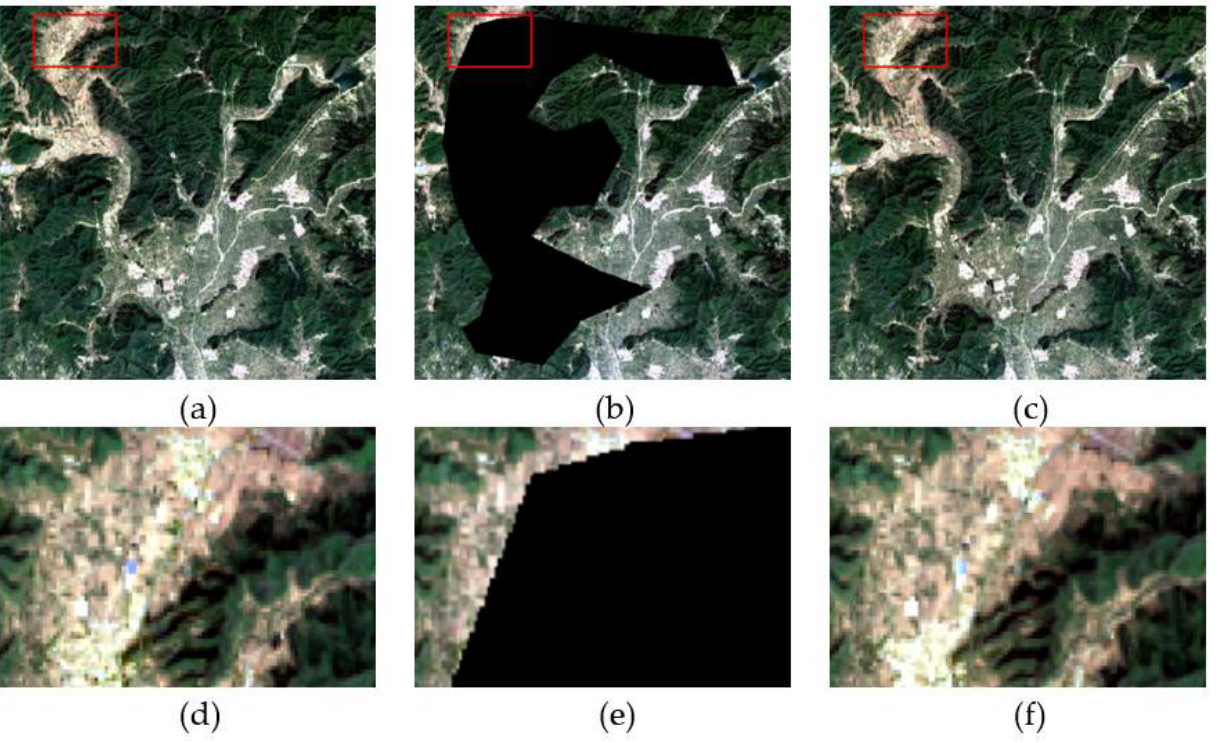
Figure 15. The simulated experiment with missing area of 32.48%: ( a ) original image; ( b ) simulated cloudy image; ( c ) reconstructed image; ( d – f ) enhanced details from red boxes in ( a – c ).